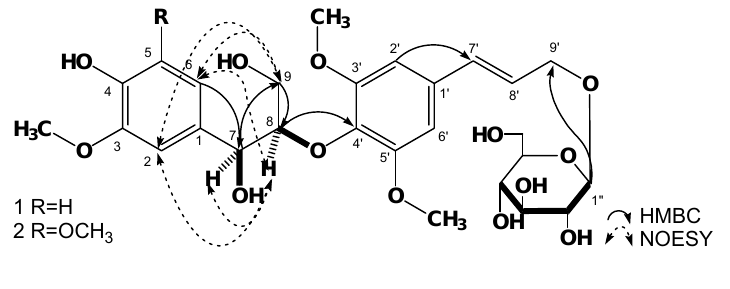
Figure 1. Structures and key HMBC, NOESY correlations of compound 1 , 2.